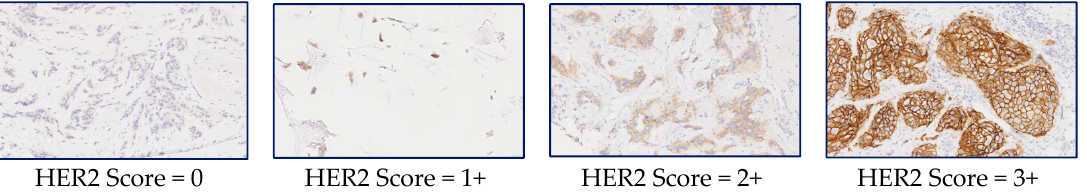
Figure 1. Whole Slide Image (WSI) tiles showing different levels of staining and their corresponding HER2 scores. Reproduced from [12] with